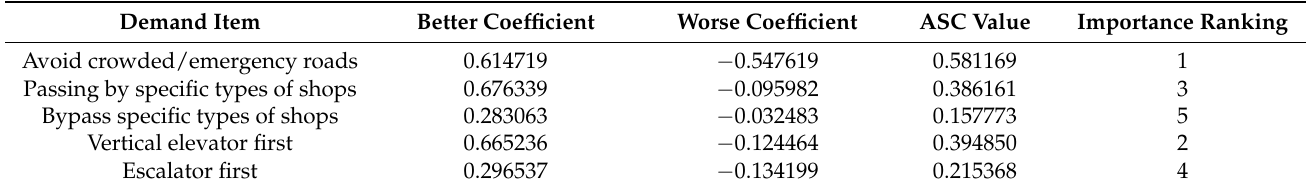
Table 12. Analysis of Better–Worse coefficient and ASC value of indoor navigation demand factors in shopping